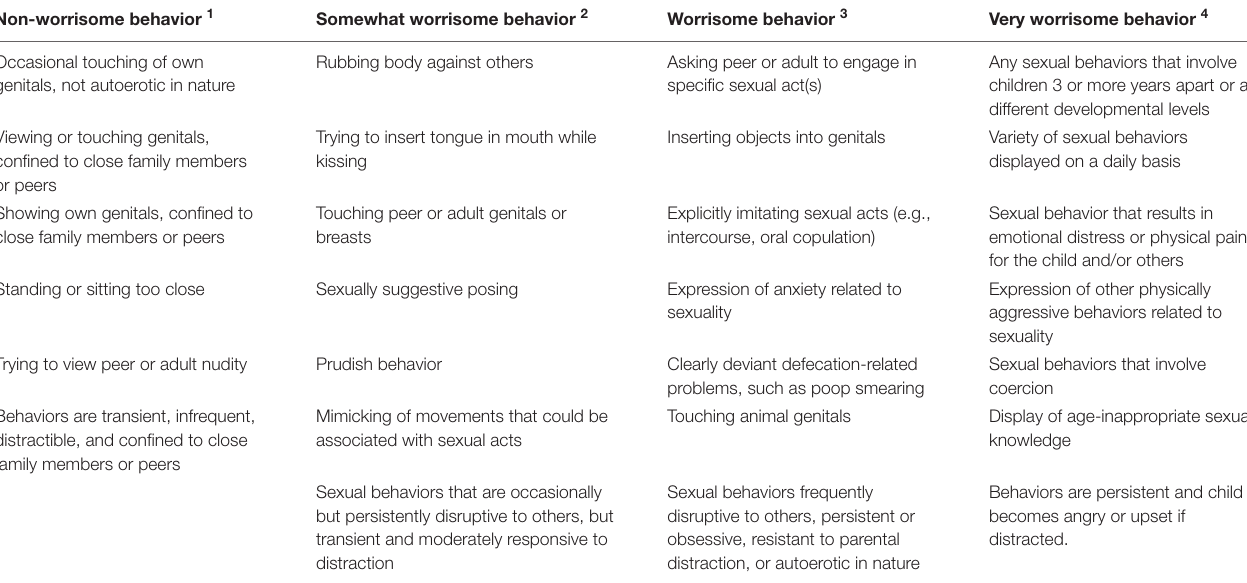
TABLE 1 | Criteria for rating child sexual behaviors reported by